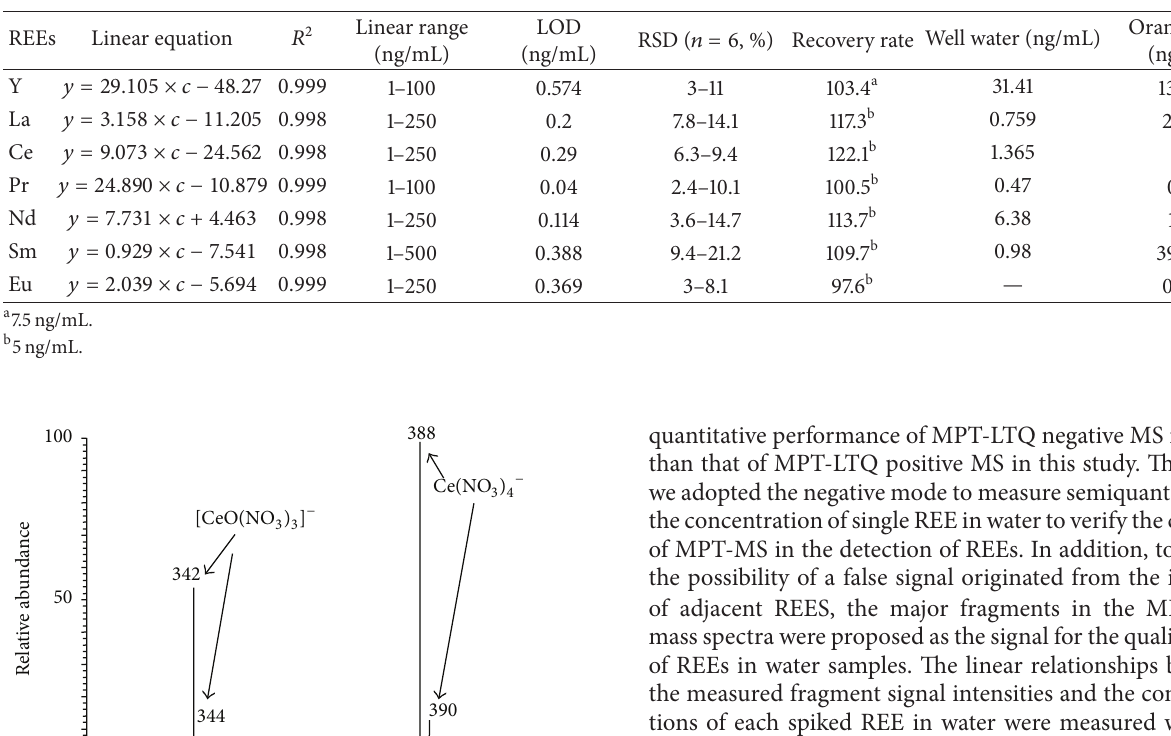
Table 2: Quantitative indexes summarized of MPT-MS 2 method for REEs in pure water and analysis results for some real samples.